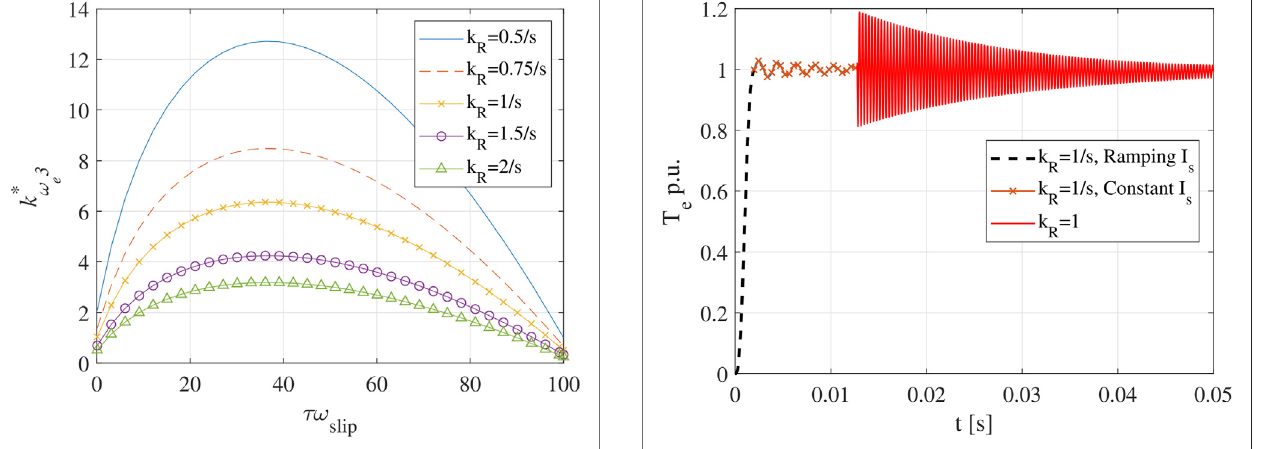
FIGURE 4 | Traditional single-step equivalent resistance method.